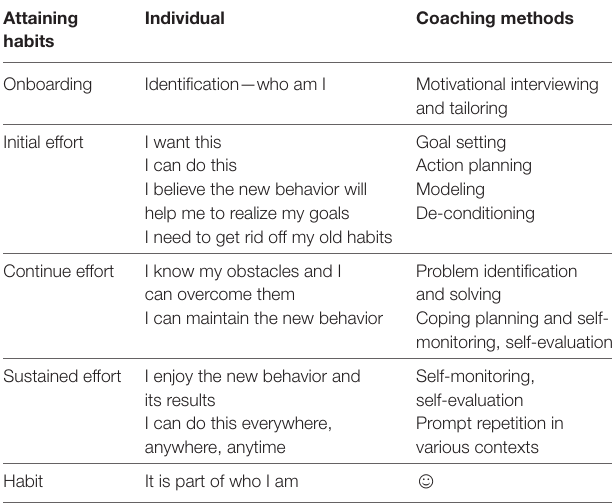
TABLe 3 | The various phases in behavioral change, together with the individual’s perspective and coaching